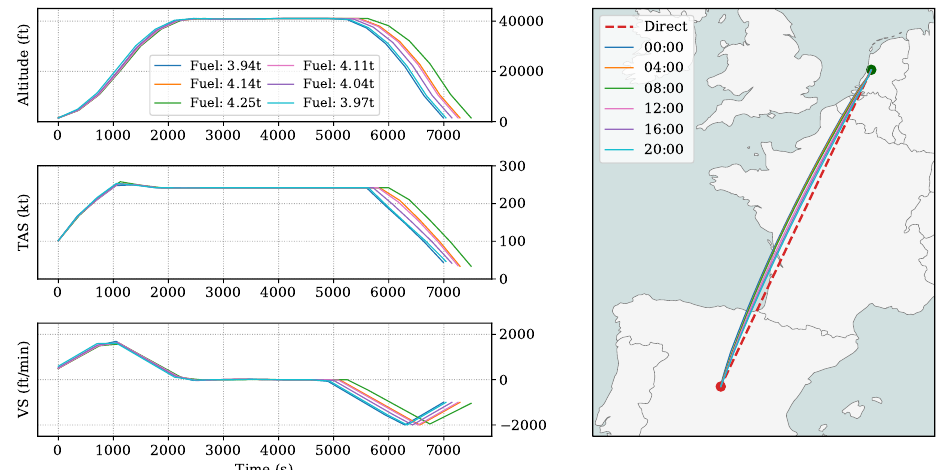
Figure 12. Optimal trajectories of the same origin and destination under different wind conditions over the course of a day.